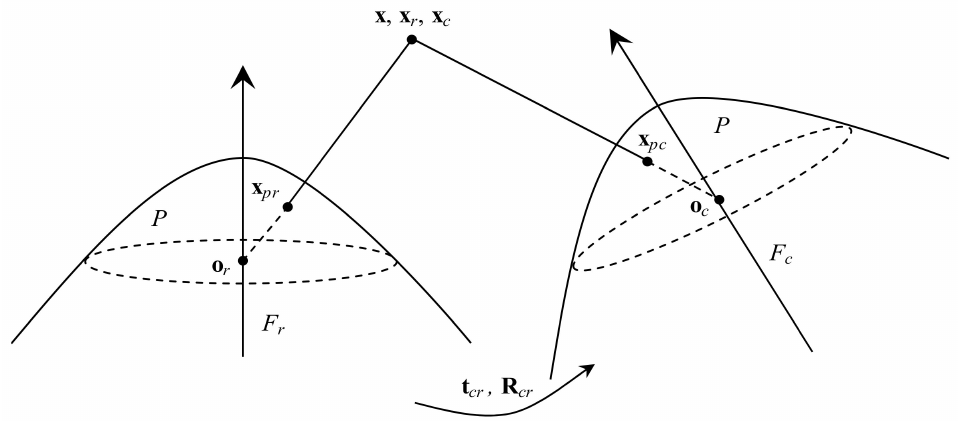
Figure 4. The points x pc and x pr back project to rays, and the intersection of the two rays is the object point x. From the new matches x pc ↔ x pr , we can recover the relative pose [ R cr | t cr ] between two frames and triangulate the point